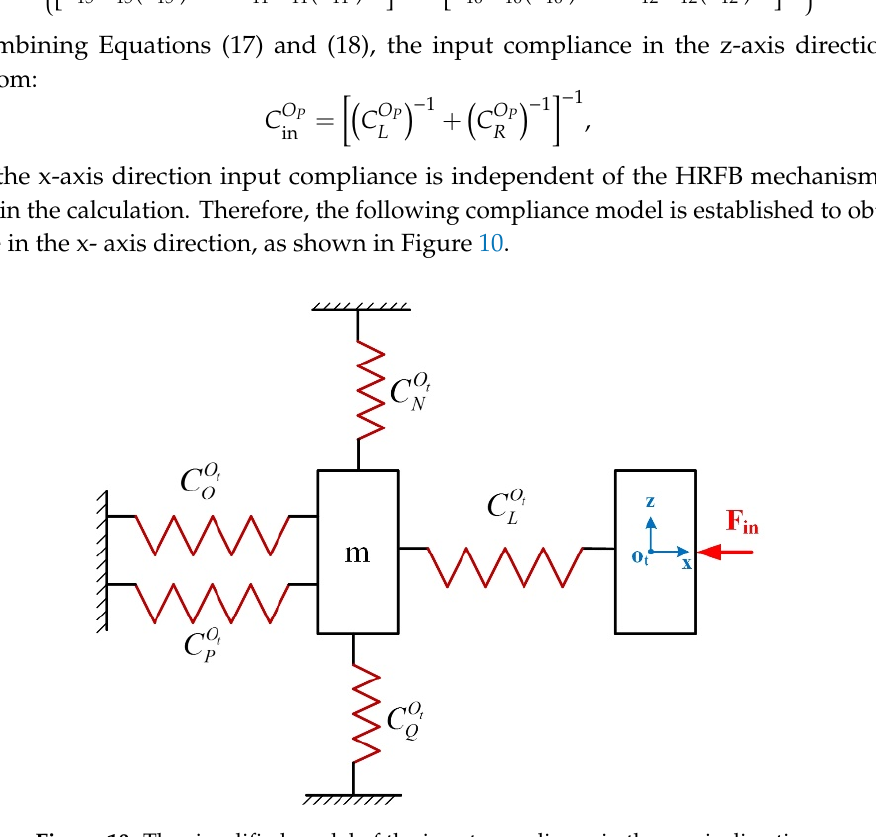
Figure 10. The simplified model of the input compliance in the x-axis